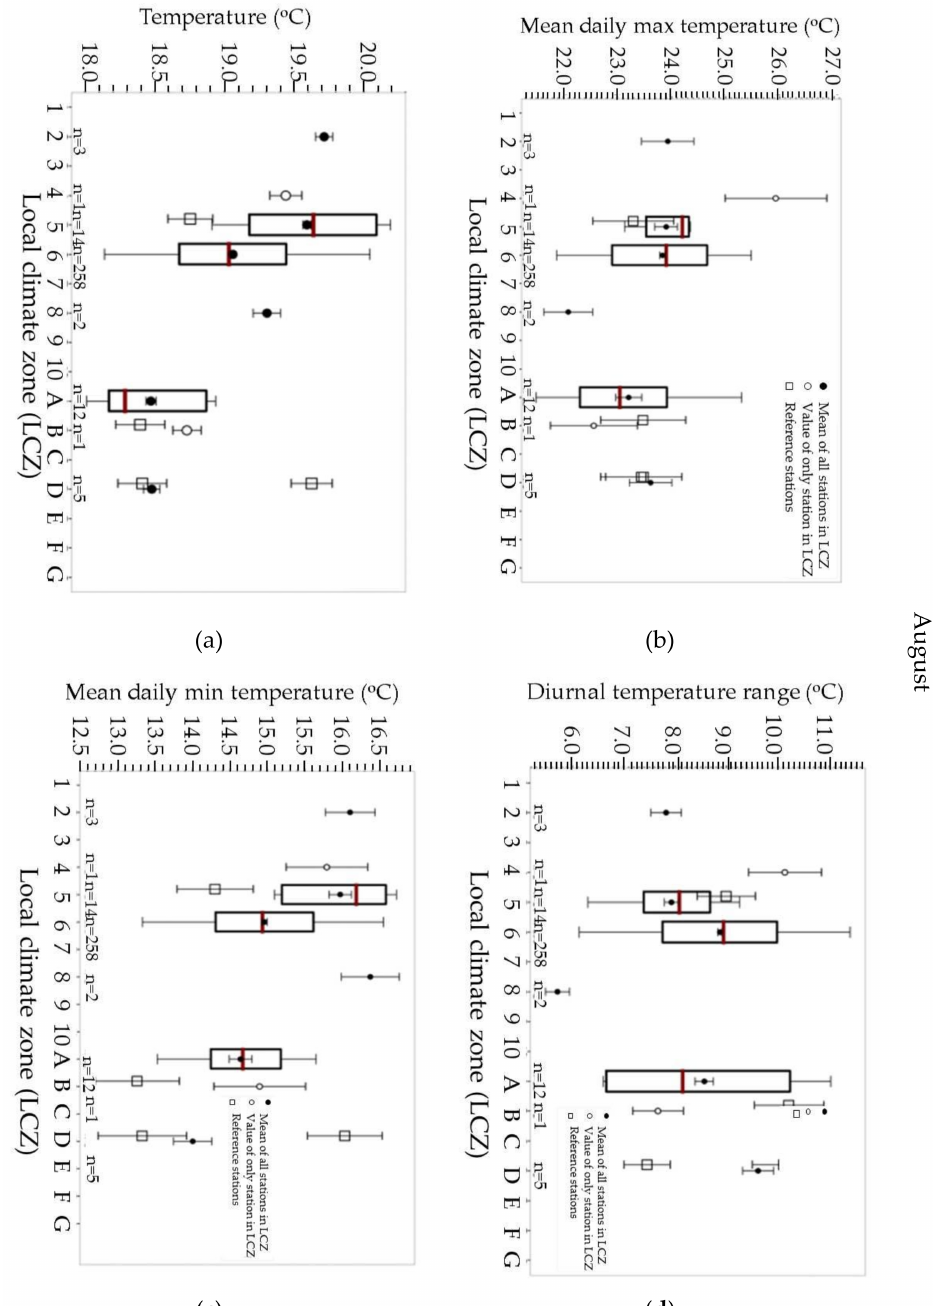
Figure A1. Local climate zone (LCZ) temperature characteristics in August 2018: ( a ) is the mean temperature over the entire month, ( b ) is the mean daily maximum temperature, ( c ) is the mean daily minimum temperature, and ( d ) is the mean diurnal temperature range. LCZs associated with urban landscapes (LCZs 1-10) are on the left side and those associated with rural landscapes (LCZs A–G) are on the right side. n represents the number of valid stations in that LCZ. Filled dots represent the mean of all Netatmo stations in each LCZ, unfilled dots represent the value of the only Netatmo station in an LCZ and squares represent values of reference stations. Box plots are also displayed for LCZs with more than ten stations present. The maroon central line represents the median, the upper and lower bands of the box are the 75th and 25th percentiles and the upper and lower whiskers are the 95th and 5th percentile. The method of error calculation of the means is shown in Appendix